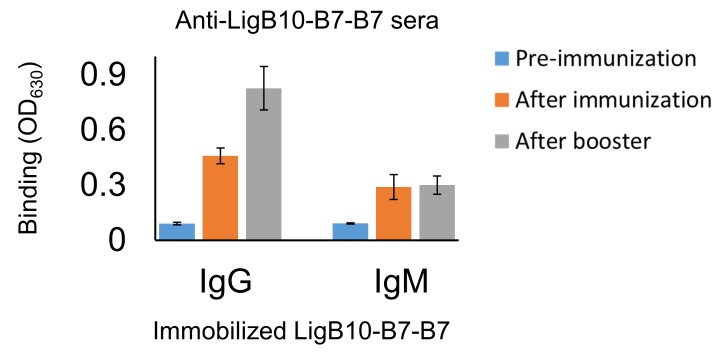
Memory response triggered by LigB10-7-7 chimera.The serological fluid of hamsters immunized with recombinant LigB10-7-7 antigen was collected before immunization, after immunization (primary response), and after the booster (secondary response). Anti-LigB10-B7-B7 sera was applied to recombinant LigB10-7-7 coated microtiter plates and tested for antigen-specific IgG or IgM using secondary antibodies (anti-hamster IgG or IgM conjugated with HRP). All experiments were conducted in three trials, the mean ± S.D. of which were shown in bar charts.